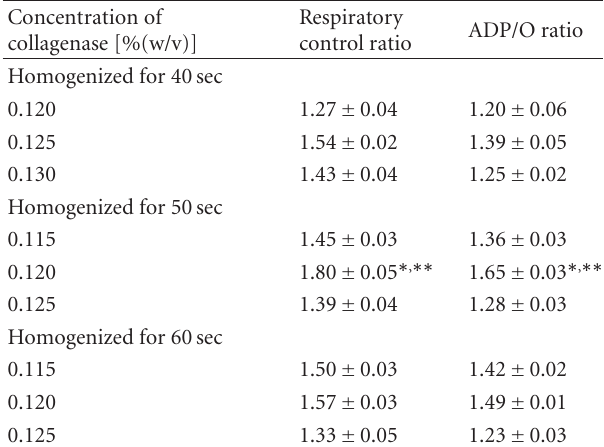
Table 2: Respiratory control ratio (RCR) and adenosine diphos- phate/oxygen (ADP/O) ratio in mitochondrial fractions from rat gingival tissues.